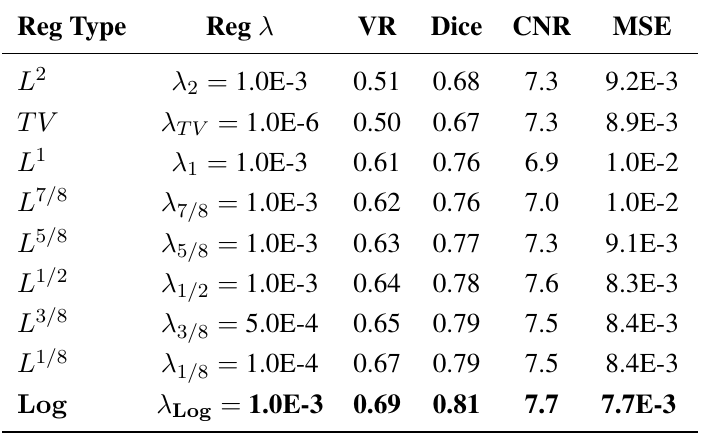
Table 3. Metrics of the best reconstructed images using individual regularizations for simulated large target, with the best regularization method highlighted in bold.